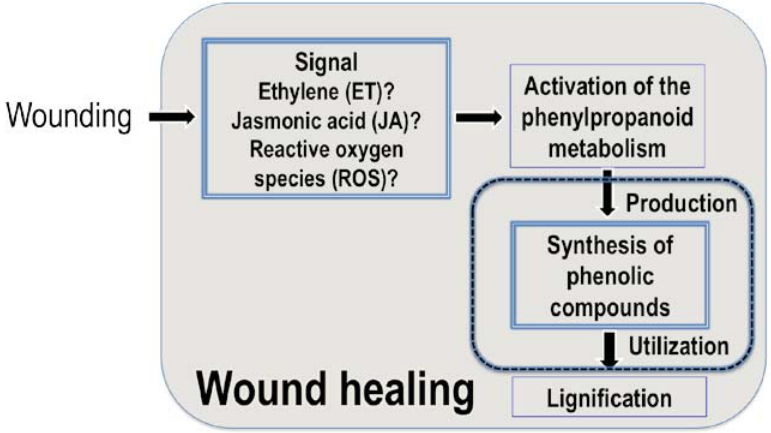
Figure 3. Accumulation of antioxidant phenolic compounds during the wound healing